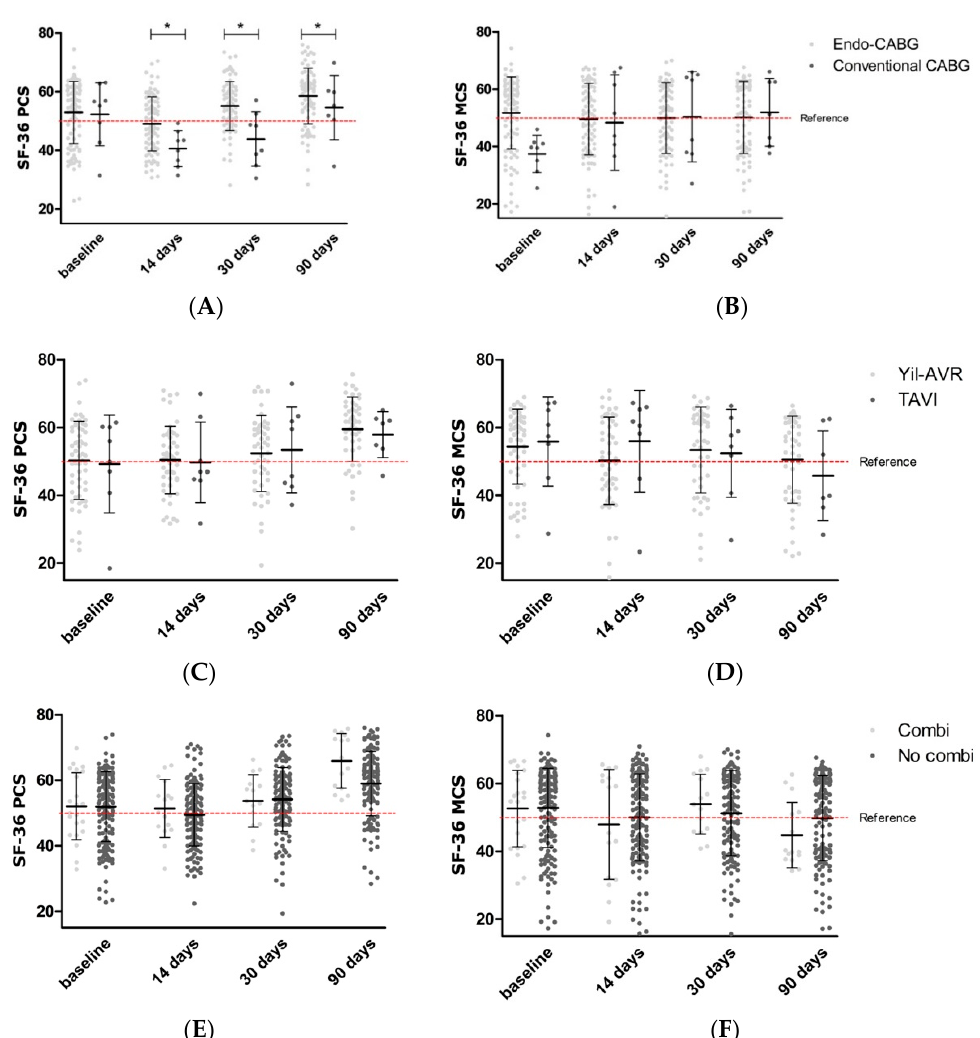
( L ) Figure 2. Different domains of the Short Form 36 (SF-36) and Euro Quality of Life (EQ-5D) questionnaires after totally endoscopic cardiac surgery. A physical component score (PCS; ( A )) and metal component score (MCS; ( B )) was calculated from the different domains of the SF-36. These included physical functioning ( E ), role limitations physical ( F ), pain ( G ), general health ( H ), role limitations emotional ( I ), emotional wellbeing ( J ), energy/fatigue ( K ) and social functioning ( L ). The EQ-5D is represented through the index value ( C ) and the Visual Analogue Scale (VAS; ( D )). Data are shown as median and interquartile ranges. The reference line represents the mean of a reference population (ischemic heart disease in Belgium). Significance is indicated as * p < 0.05; ** p < 0.001.